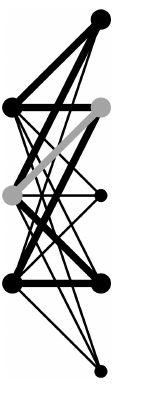
Figure 17. K 3,5 with a cycle highlighted in black and a chording edge highlighted in gray.